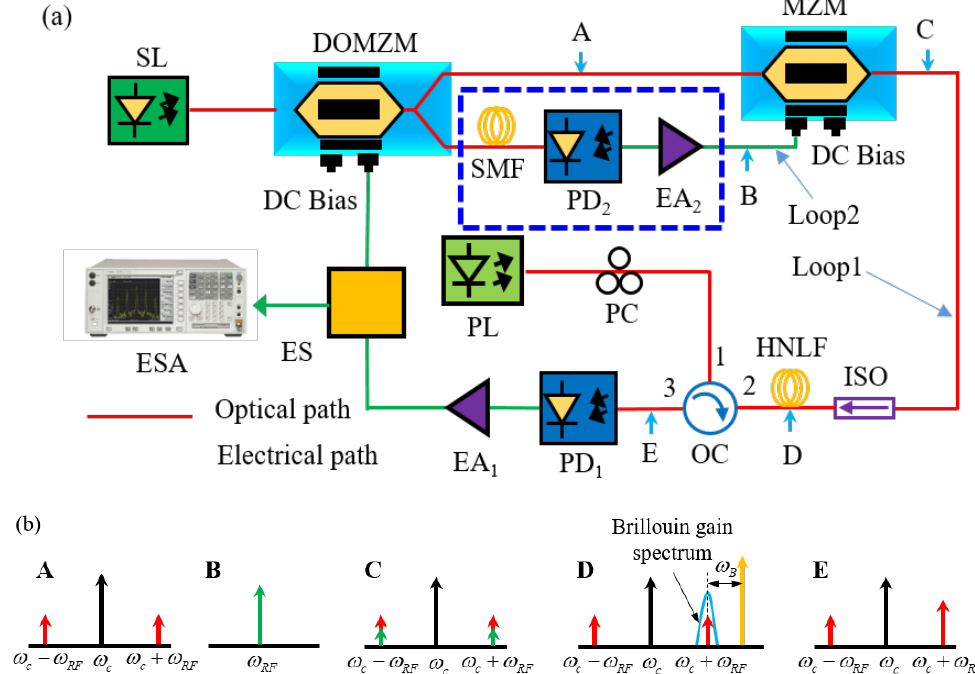
Figure 1. ( a ) Schematic diagram of the the coupled dual-loop stimulated Brillouin scattering (SBS)-based tunable optoelectronic oscillator (TOEO). SL: signal laser; DOMZM: dual-output Mach–Zehnder intensity modulator; SMF: single mode fiber; PD, photodetector; MZM: Mach–Zehnder intensity modulator; ISO: optical isolator; HNLF, high non-linear fiber; OC: optical circulator; PL, pumped laser; PC, polarization controller; EA: electrical amplifier; ES, electrical splitter. ( b ) The spectrums at different point of the TOEO.